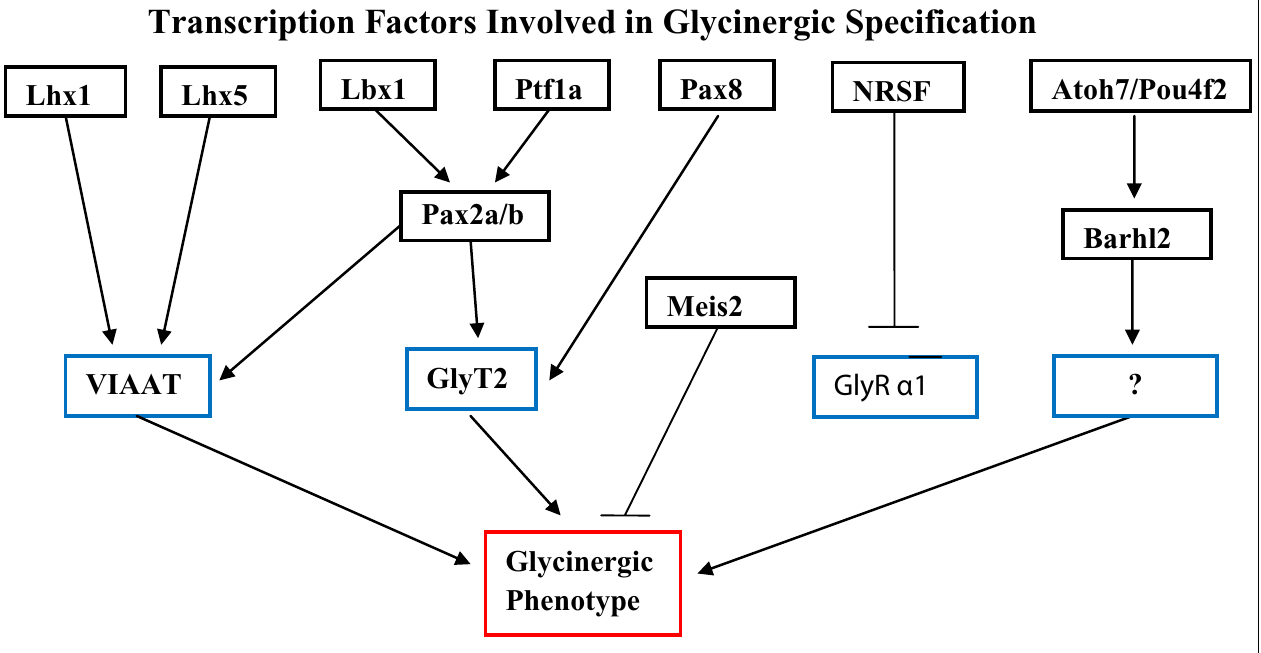
FIGURE 1 | A model for the roles of transcription factors Ptf1a, Lbx1, Pax2a/ b, Pax8, Lhx1, Lhx5 and NRSF in regulating terminal differentiation genes of glycinergic neurons based upon current literature cited in text. Lbx1 and Ptf1a act together to control Pax2-dependent expression of VIAAT and GlyT2.